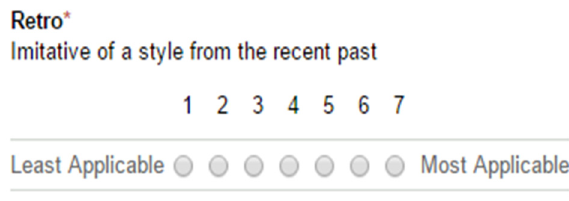
Machines 2022 , 10 , x FOR PEER REVIEW Figure 4. Main attributes of camera design specifications. Figure 4. Main attributes of camera design specifications.